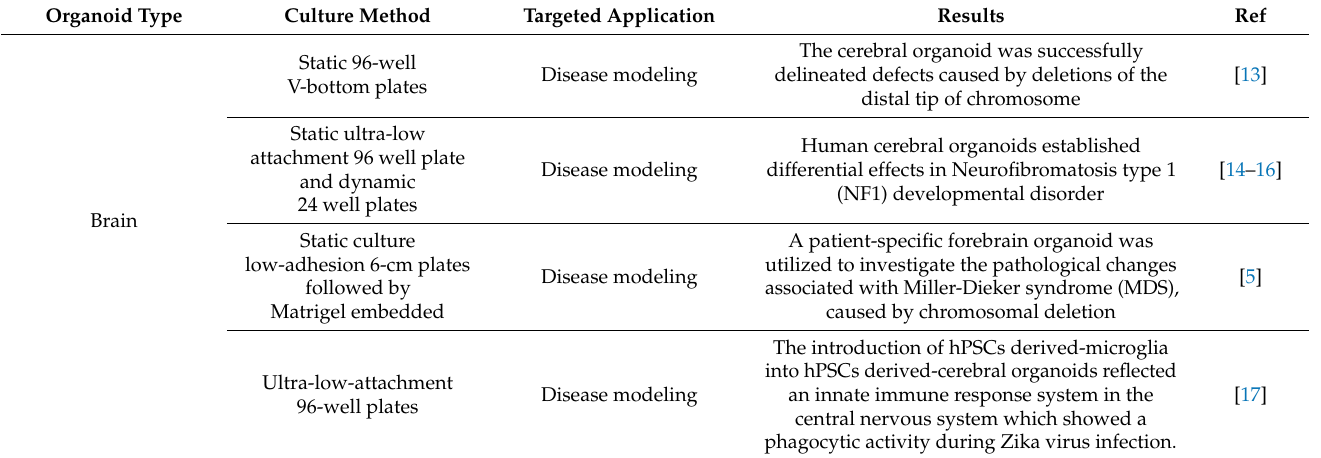
Table 1. Selected study of hPSCs derived organoids and their targeted